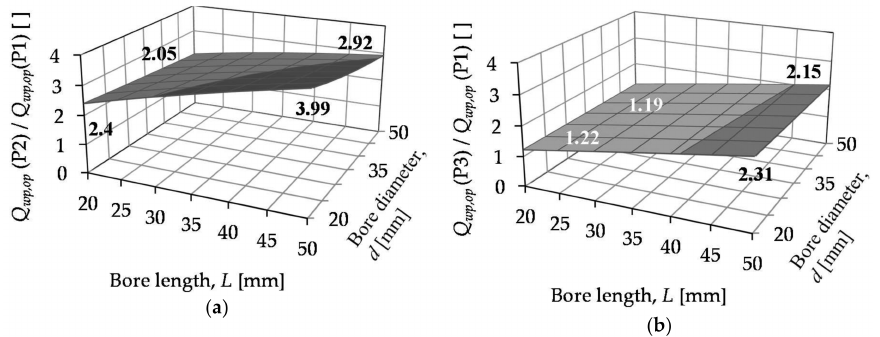
Figure 7. Rates of material removal rates of hard turning ( a ) and the combined procedure ( b ) compared to